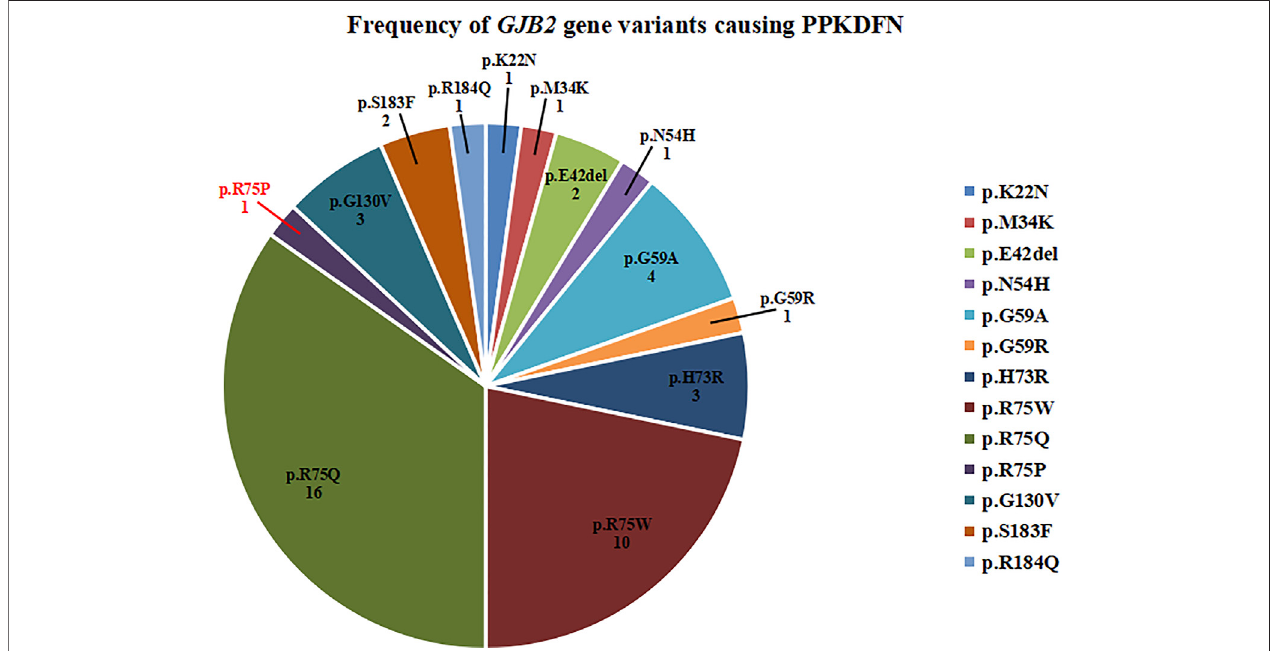
FIGURE 3 | Frequency of GJB2 gene variants causing PPKDFN. p.R75Q and p.R75W are hotspot variants of PPKDFN.